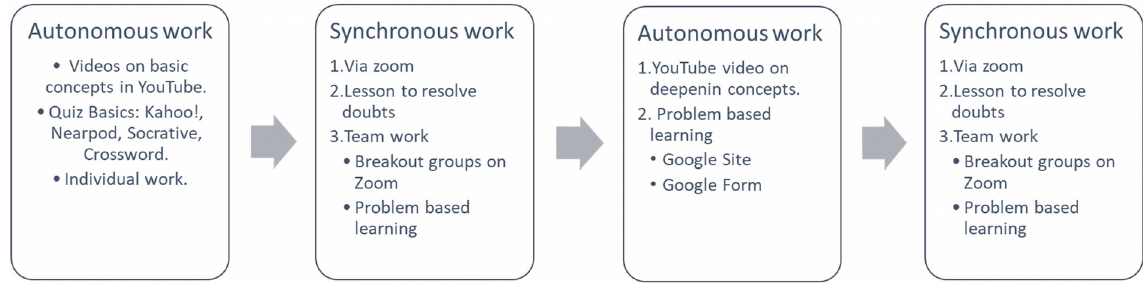
Figure 5. Selection of tools according to the initial survey for a learning